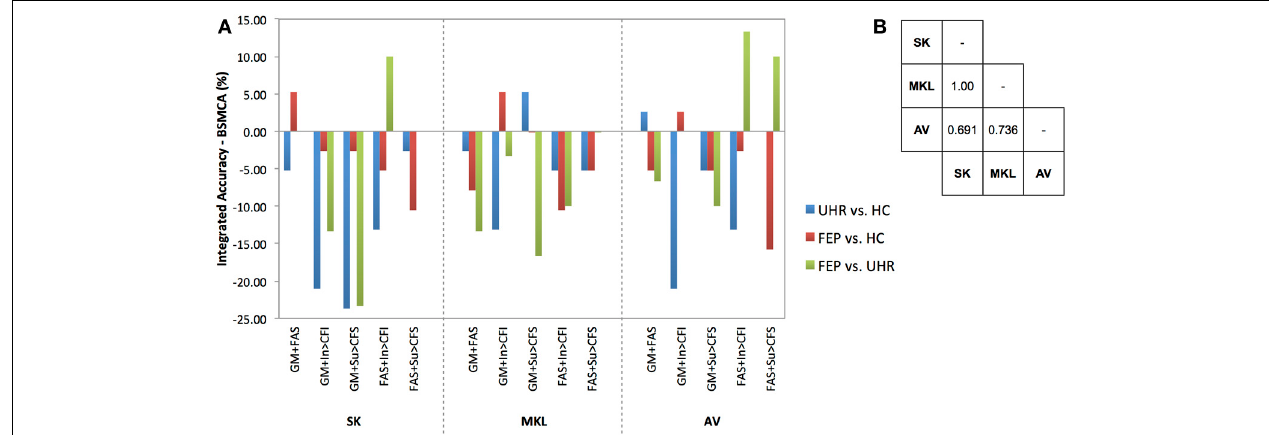
FIGURE 3 | (A) Difference between the integrated accuracy achieved using SK, MKL, or AV, and the BSMCA, discriminating UHR and FEP subjects from HCs, and each other, using two-way combinations of sMRI, DTI, and fMRI data. (B) Results of McNemar’s tests comparing subject classifications achieved by each integrative method collapsed across SVM contrasts and data combinations. SK, Un-weighted simple sum of kernels; MKL, Multi-Kernel